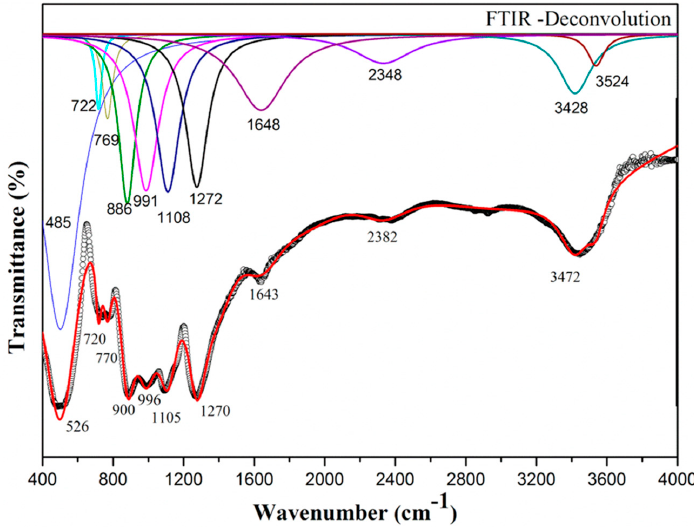
Figure 7. Deconvoluted FTIR spectra of the glass (Z2) and curve fit.